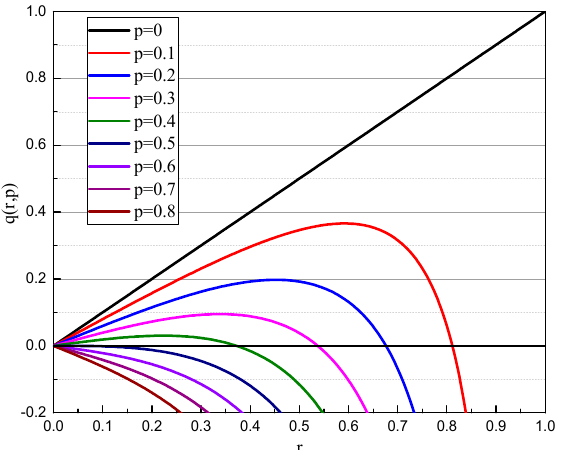
Figure 8. q ( r , p ) curves for undeformed gyroscope.